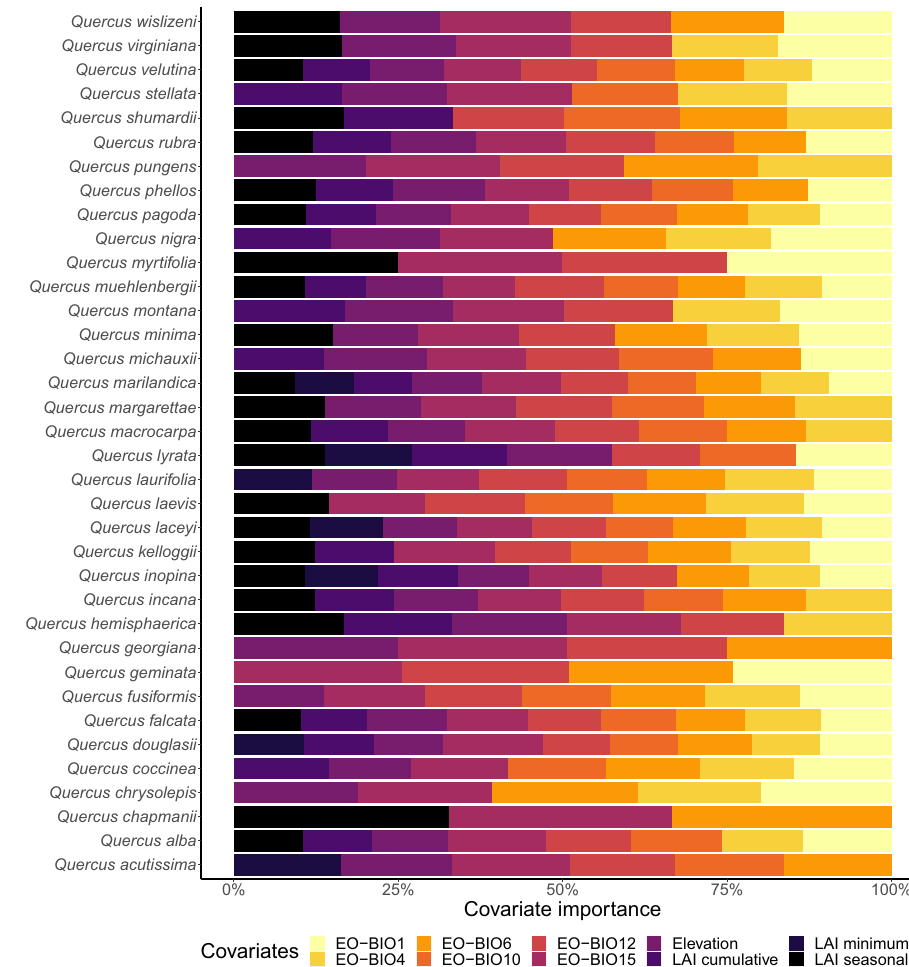
Figure 1. Covariate importance or the relative contributions (%) of the 10 covariates used for modeling the potential distribution of oak species in the Continental United